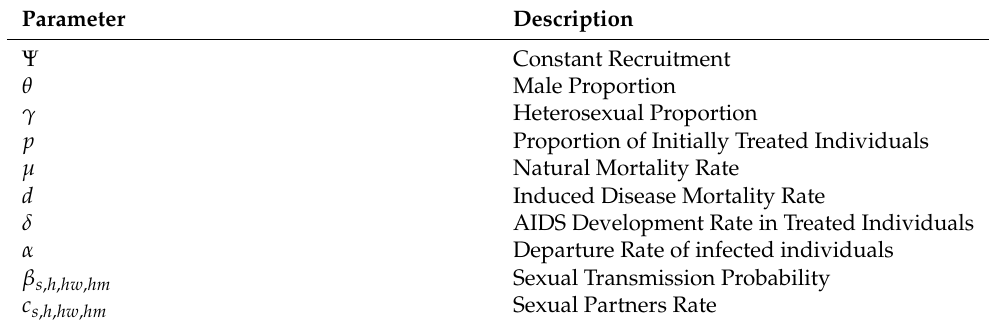
Table 1. Description of Parameters. Adapted from